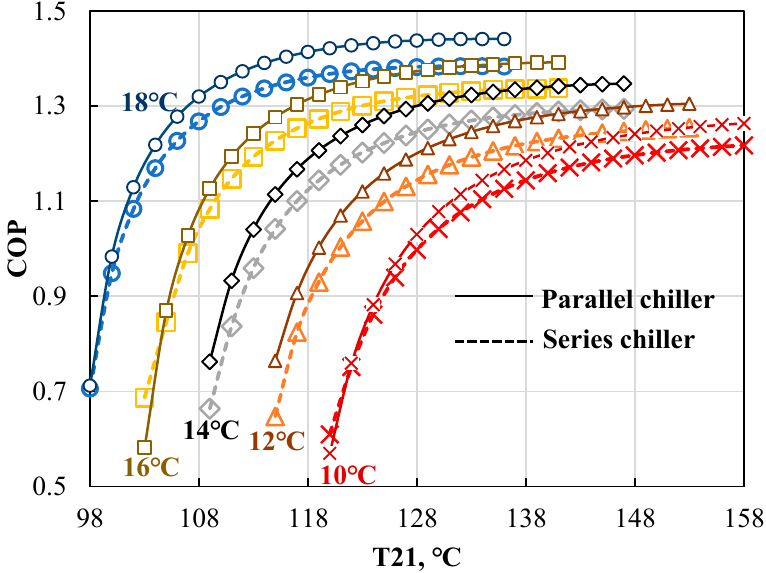
Figure 8. Variation of COP with the two types of absorption chillers as a function of chilled water temperature and steam temperature (T21).